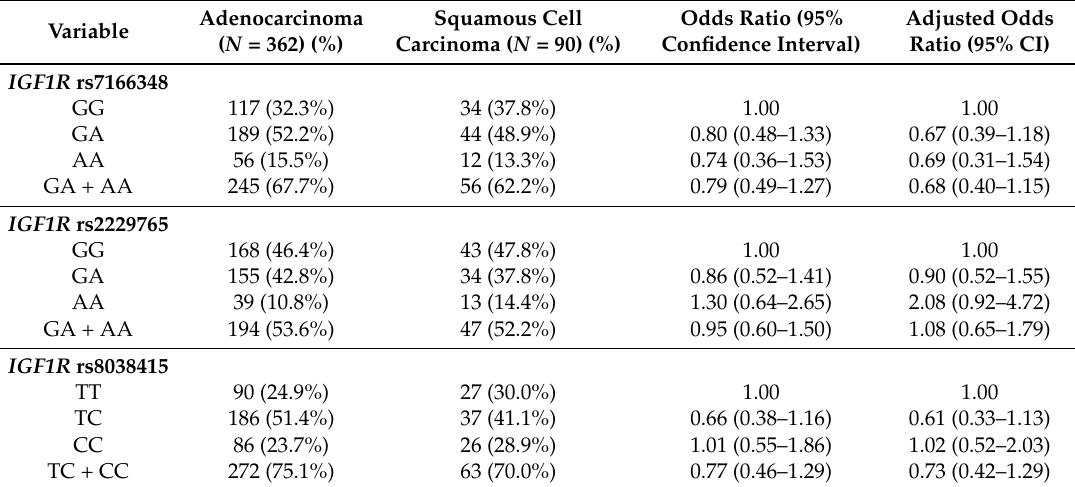
Table 2. Distribution frequency of insulin-like growth factor 1 receptor (IGF1R) genotypes in 362 lung adenocarcinoma and 90 lung squamous cell carcinoma.